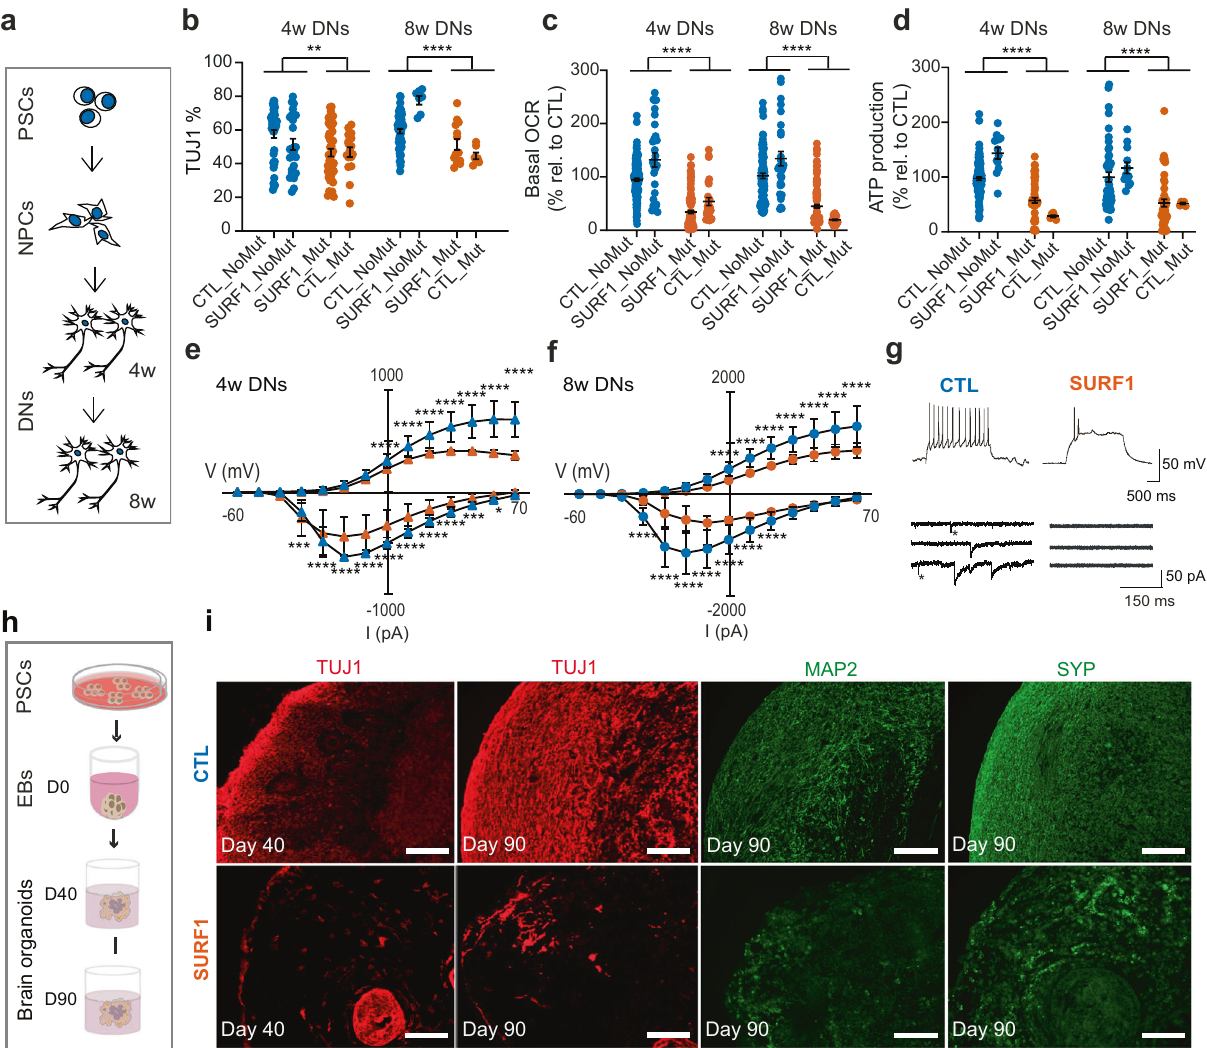
Fig. 2 SURF1 mutations impair neuronal maturation in 2D and 3D cultures. a 2D differentiation into mature differentiated neurons (DNs). We analyzed DNs at 4 weeks (4w) and 8 weeks (8w) starting from NPCs. b HCA quanti fi cation of TUJ1 + neurons in 4w and 8w DNs from CTL (CTL_NoMut: C1, C2, C3; SURF1_NoMut: S2_Corr1, S2_Corr2) and SURF1 (SURF1_Mut: S1, S2; CTL_Mut: C1_Mut1) (mean ± s.e.m.; each dot represents a biological replicate; n